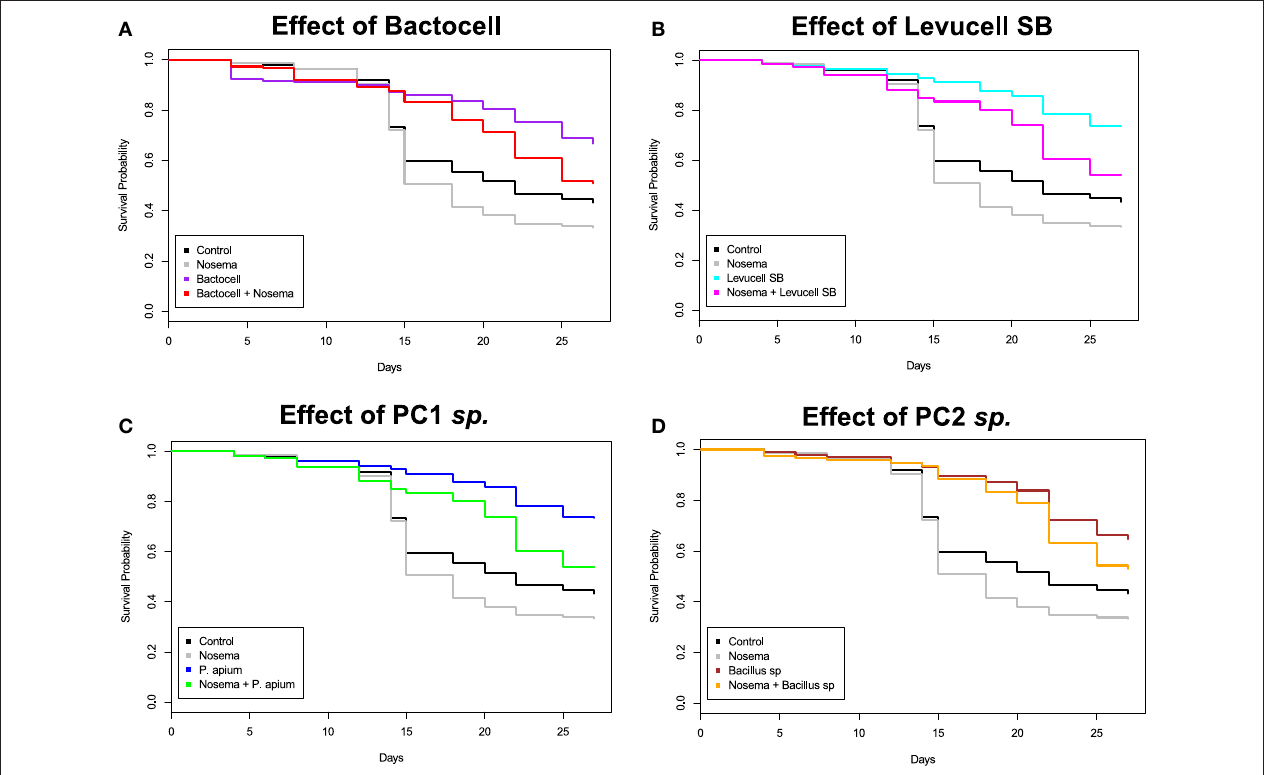
FIGURE 3 | Kaplan-Meier Survival curves distribution of bees in each experimental group during the 27 days cage bee experiment. The y-axis represents the Kaplan-Meier estimates of the survival probabilities. The x-axis represents the experimental days. (A) Effect of Bactocell ® administration (prophylactic: Bactocell ® group and curative: Nosema + Bactocell) on honeybee survival. (B) Effect of Levucell ® administration (prophylactic: Levucell group and curative: Nosema + Levucell) on honeybee survival. (C) Effect of PC1 sp. ( Parasaccharibacter apium probiotic candidate) administration (prophylactic: PC1 sp. group and curative: Nosema + PC1 sp.) on honeybee survival (D) Effect of PC2 sp . ( Bacillus probiotic candidate) administration (prophylactic: PC2 sp. group and curative: Nosema + PC2 sp.) on honeybee survival.